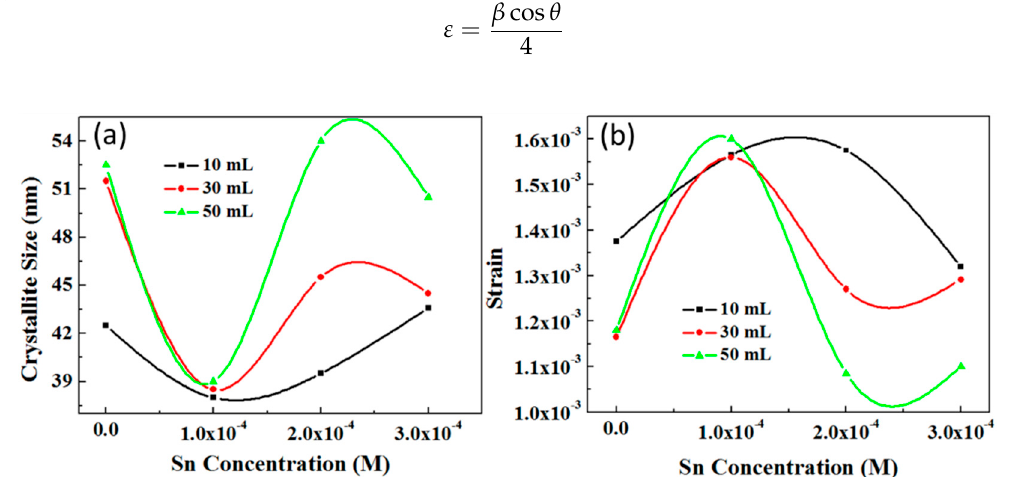
Figure 3. Variation in the ( a ) crystallite size and ( b ) strain of Sn:CdO films with Sn concentration and volume.